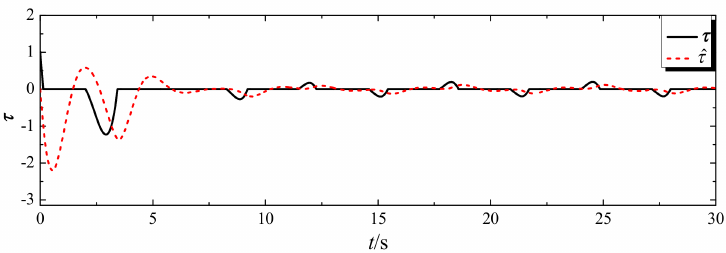
Figure 10. Compensation of the RBF neural network.